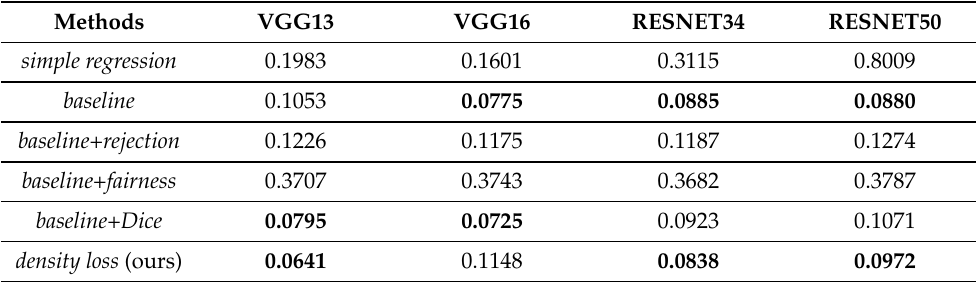
Table 2. Average distance (see Section 3.1) between true and predicted class distribution for different methods and backbones on SVNH . The two best results are in bold.